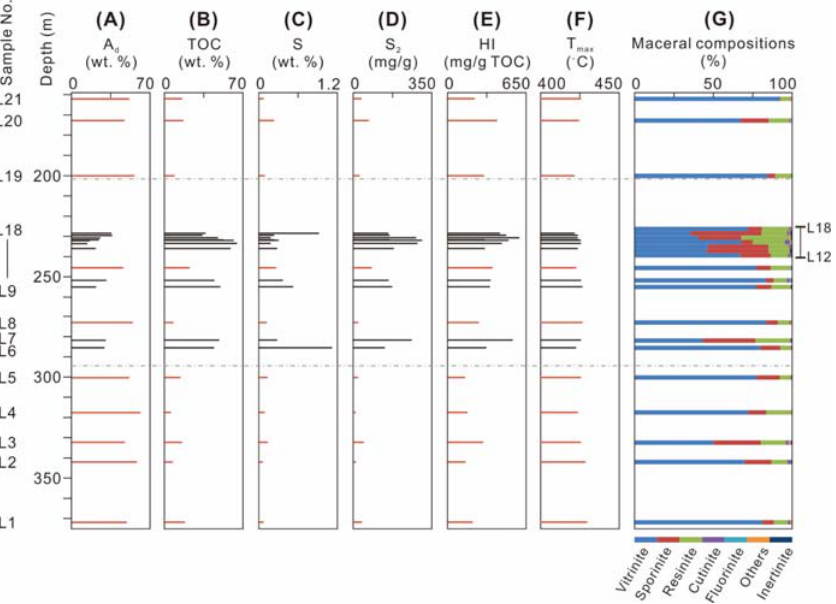
Figure 3. Bulk geochemical parameters of oil shale and coal in the N1. ( A ) Ash yield, dry basis (A d ). ( B ) Total organic carbon (TOC). ( C ) Total sulfur (TS). ( D ) The hydrocarbons cracked from kerogen during pyrolysis (S 2 ). ( E ) Hydrogen index (HI). ( F ) The temperature of maximum generation (T max ). ( G ) Maceral compositions; others represent other liptinites, including alginite, suberinite, and liptodetrinite. The red bar represents oil shale and the black bar represents coal. Two horizontal grey lines shows the boundaries of three units.